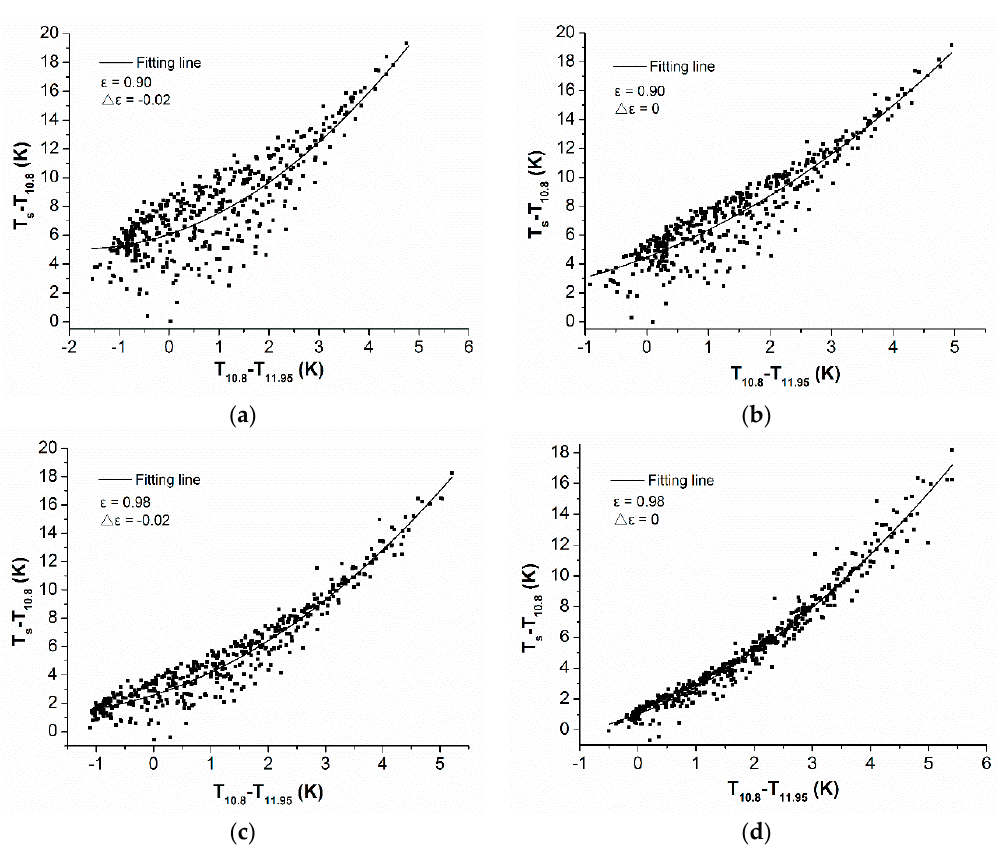
Figure 5. Variations of ( T s − T 10.8 ) versus ( T 10.8 − T 11.95 ) for the emissivity combinations of ( a ) ε = 0.90 and Δε = − 0.02, ( b ) ε = 0.90 and Δε = 0, ( c ) ε = 0.98 and Δε = − 0.02 and ( d ) ε = 0.98 and Δε = 0. Here, ε is the mean emissivity of the two channels and Δε denotes the emissivity difference.